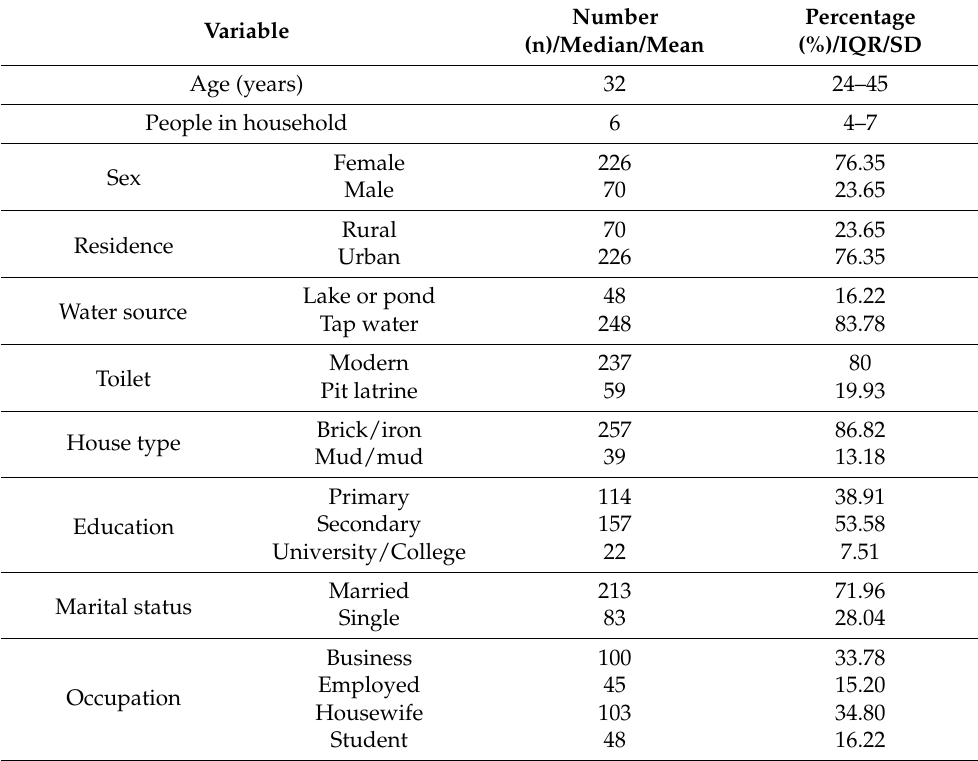
Table 2. Sociodemographic characteristics of 296 febrile adults in Mwanza,